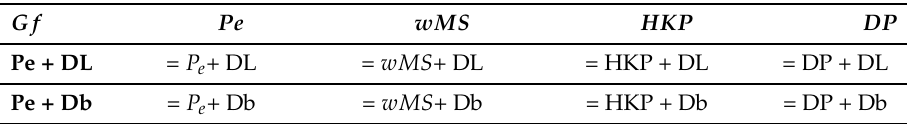
Table 4. Γ = G + f . Arbitrary G and f .